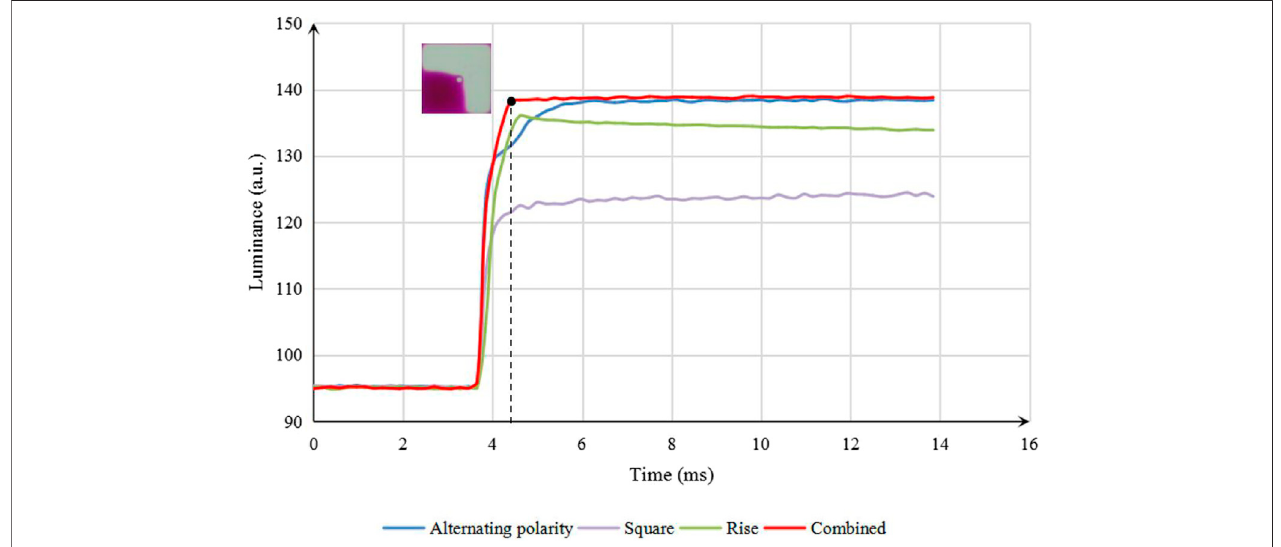
FIGURE 11 | Luminance – time curve of an EWD panel with four different driving waveforms. The traditional square waveform, the existing rising gradient driving waveform proposed by Zhang [21], the asymmetrical alternating polarity driving waveform proposed by Chen [20], and the proposed combined driving waveform in this study.